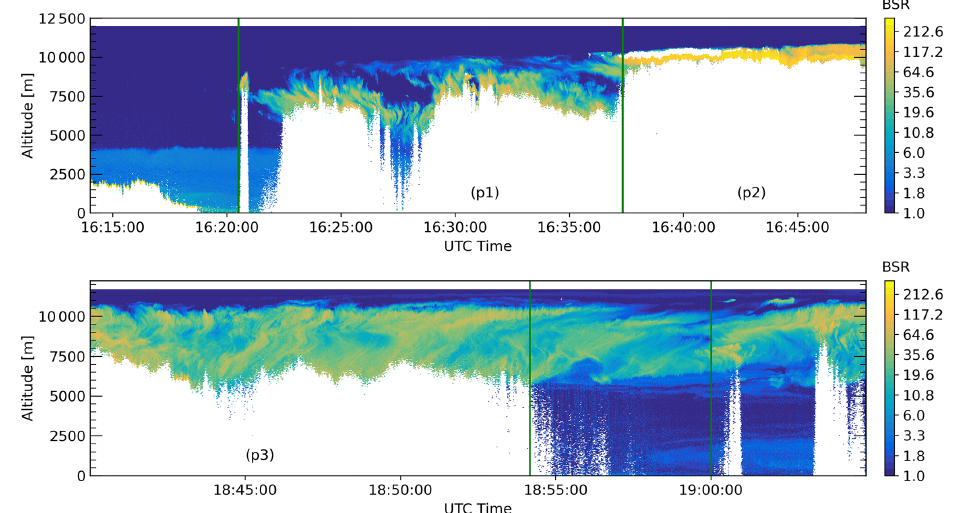
Figure 6. Backscatter ratio (BSR) measured by WALES lidar at 532nm (color coded). Two lidar legs performed during Mission 6 of the ML-CIRRUS campaign on 29 March 2014 over the west Mediterranean, depicting a mesoscale convective system. p1 contains two towering convective cells. p2 contains the main convective cell. p3 depicts the outflow of the system. The white regions at the cloud top are a result of saturation of the detector. The clouds in p1 and especially p2 are not fully depicted, and only the top portions of the cloud could be measured by the lidar system.